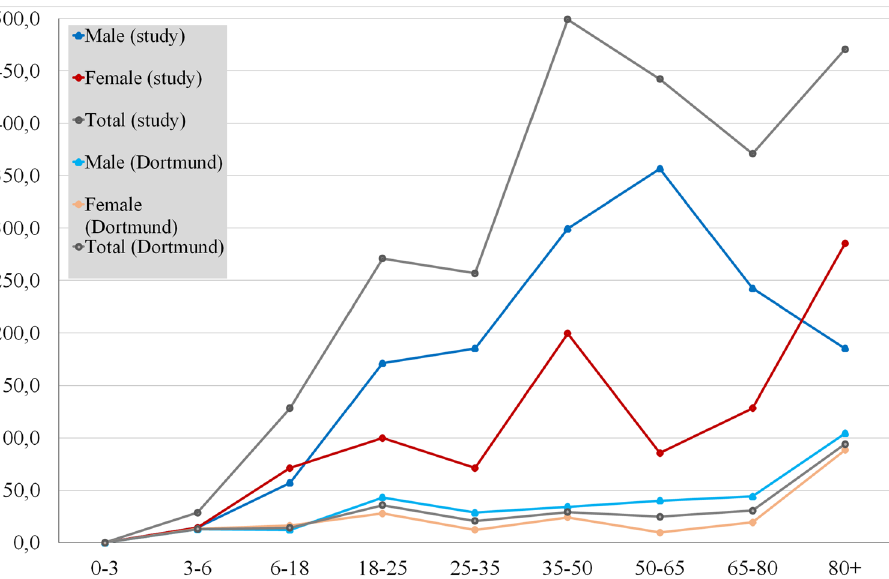
Figure 3. The incidence of CSI in the study population and MFI–CSI incidence in the whole population of Dortmund (1/100.000 inhabitants).